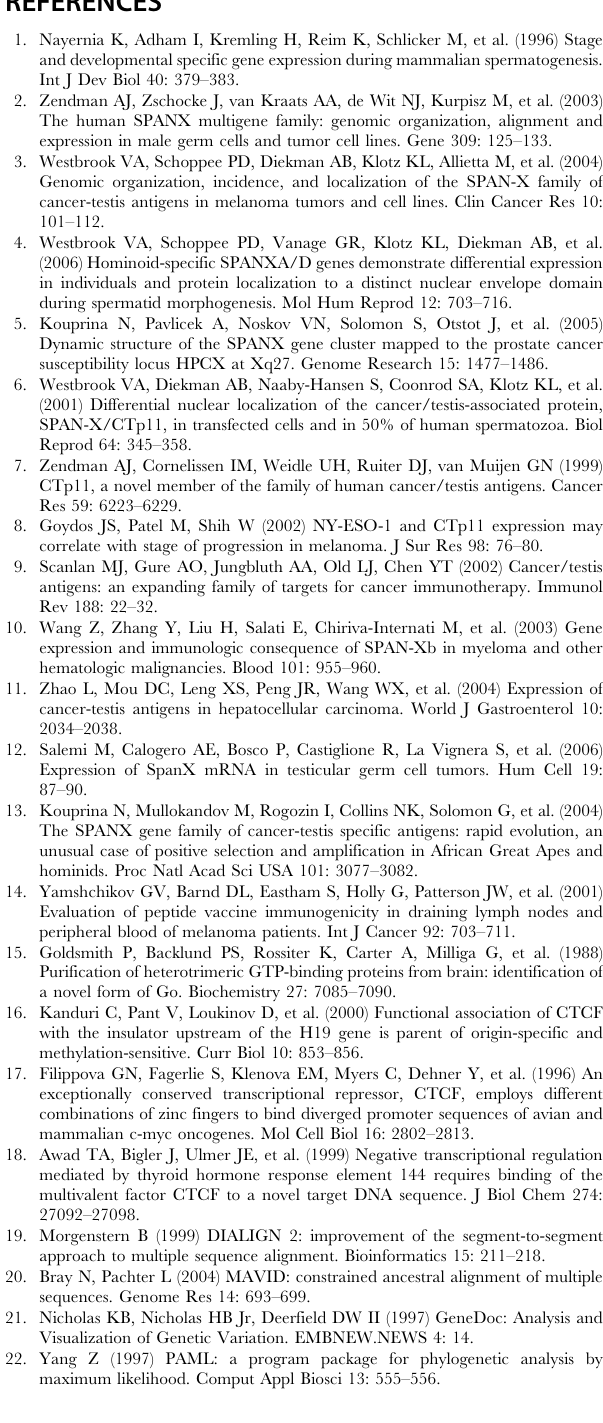
Table S4 Nucleotide and amino acid variants in the canine SPANX-N coding